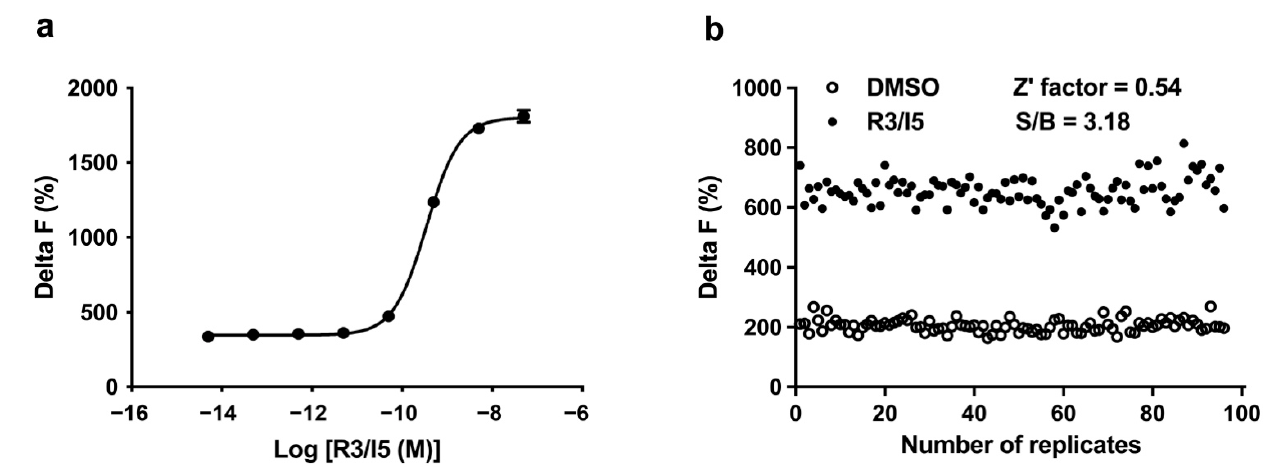
Figure 1. Validation of the HTS assay. ( a ) Concentration-dependent agonistic activity of R3/I5 in hRXFP3-CHO cells under the optimized assay conditions. ( b ) Z’ factor determination. A total of 192 replicates of R3/I5 and background signals were studied.